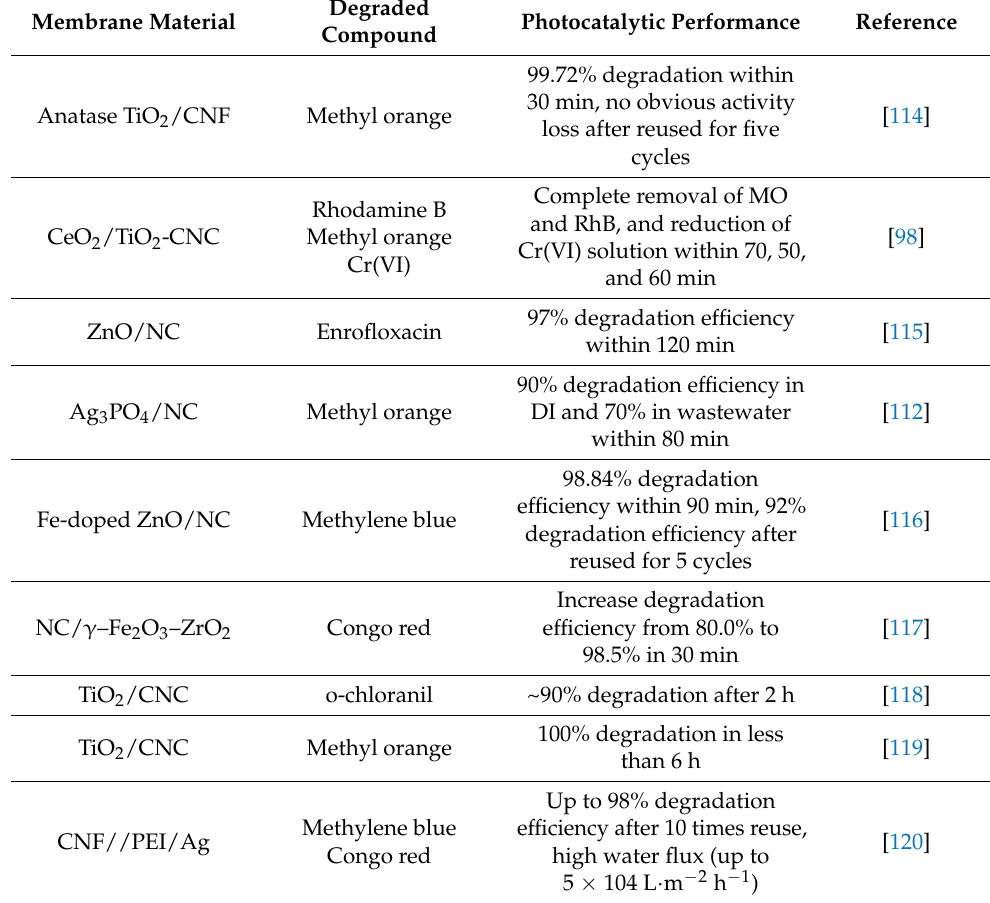
Table 5. Nanocellulose-based photocatalysts for pollutant